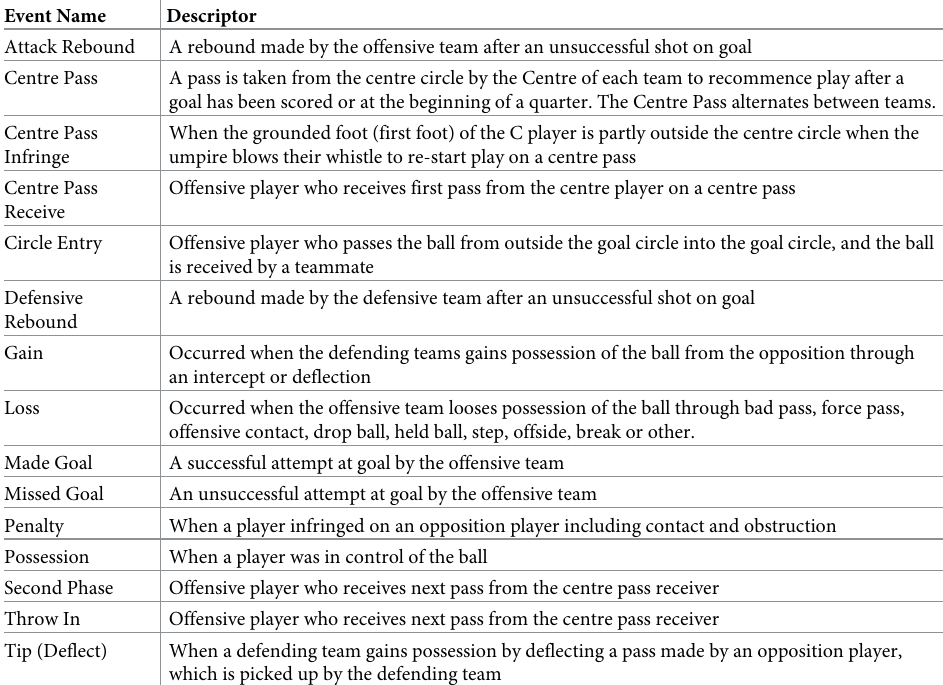
Table 4. List of events for which frequency counts were obtained from coded